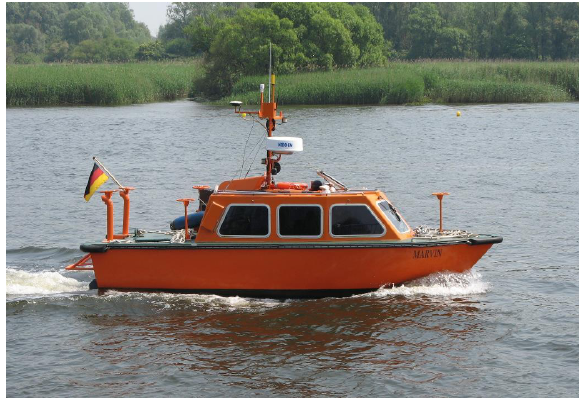
Figure 3: "Marvin", the survey vessel used in the